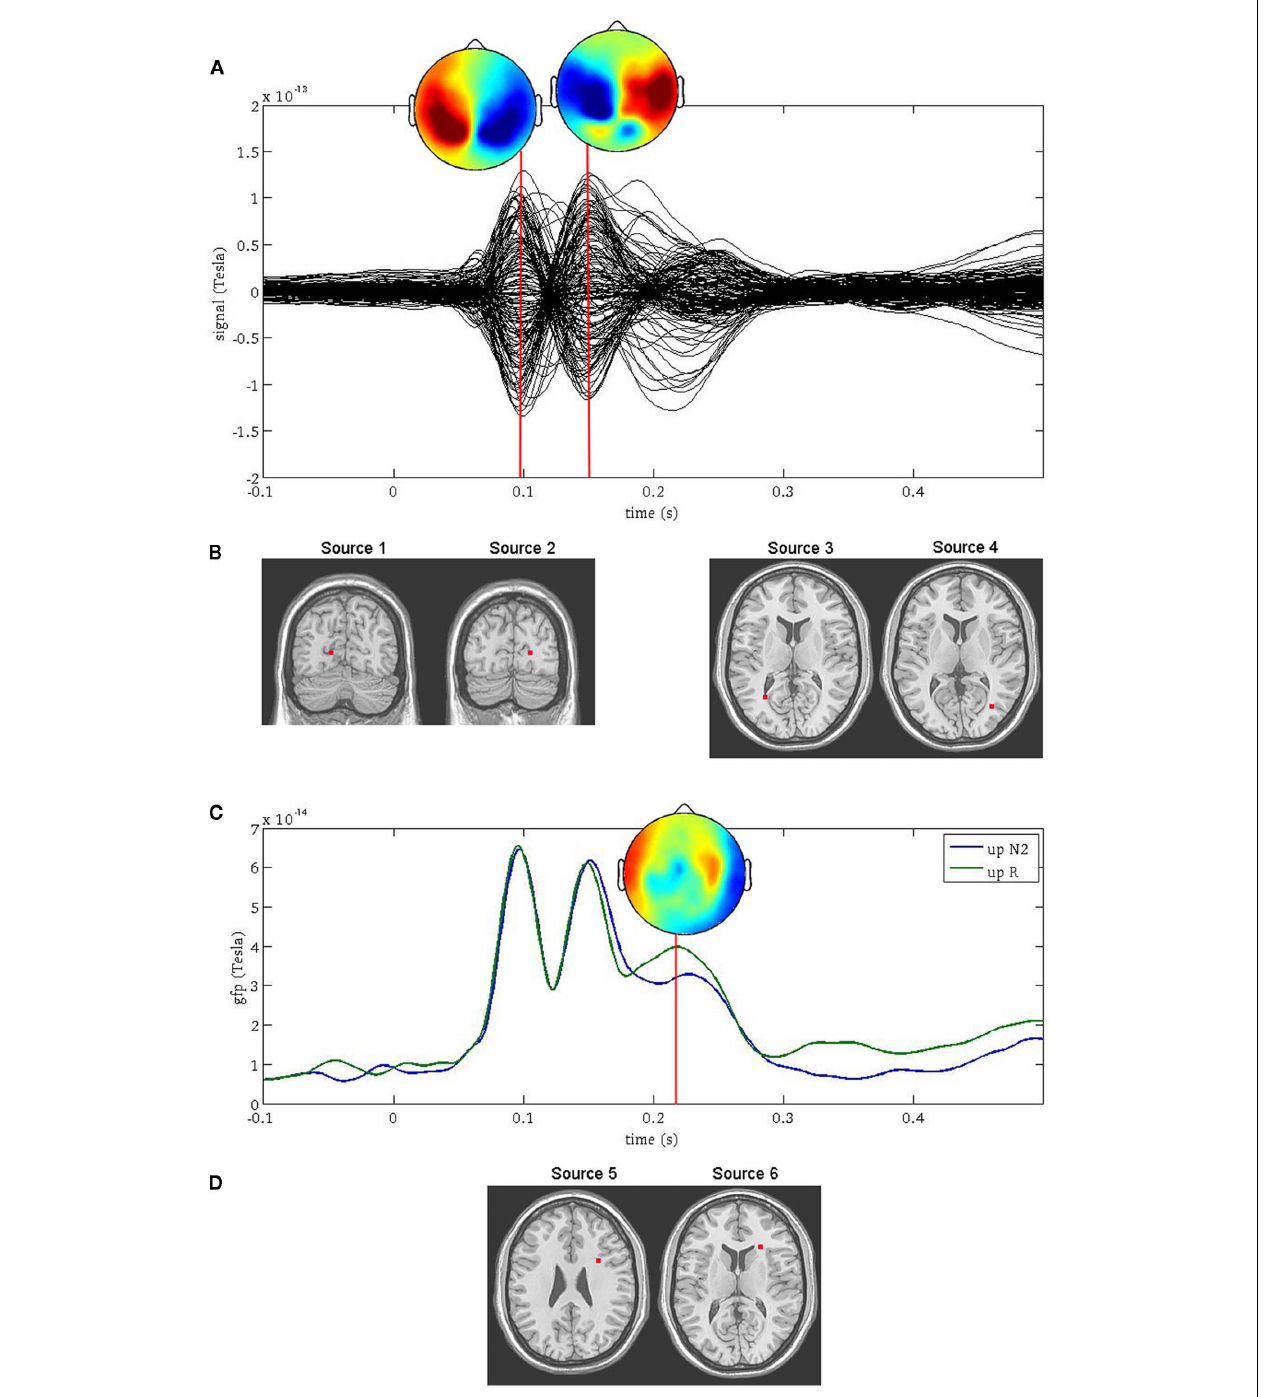
FIGURE 1 | Source reconstruction using ERB. The first two peaks in the surface fields (A) were directly localized to the left and right primary visual cortex [sources 1 and 2, (B) left] and the left and right occipito-temporal cortex [sources 3 and 4, (B) right].The third peak [sources 5 and 6, (D) ] was not localized directly from the surface field ERFs, but rather at the latency at which the difference in global field power (GFP) was greatest between the N2 and R conditions (C) .